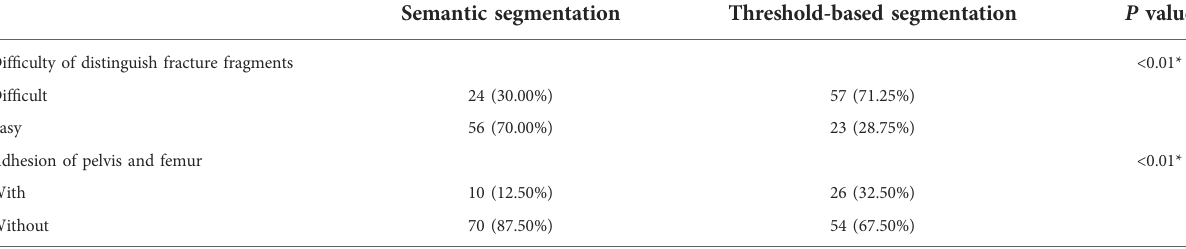
TABLE 5 The evaluation of segmentation accuracy of 2D masks generated from semantic segmentation and threshold-based segmentation.